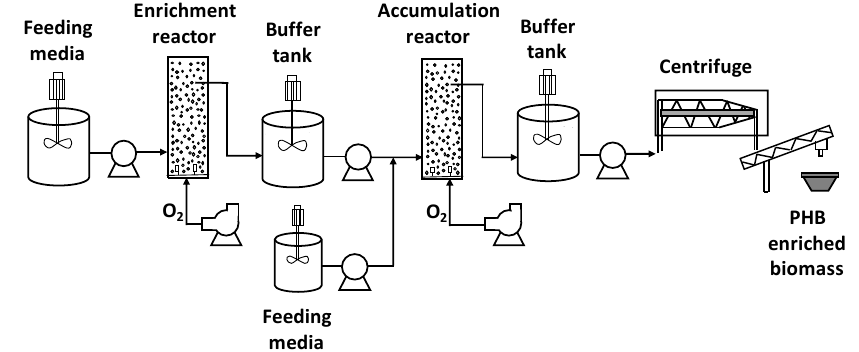
Figure 1. Process considered for costs estimation of biomass-enriched PHB.